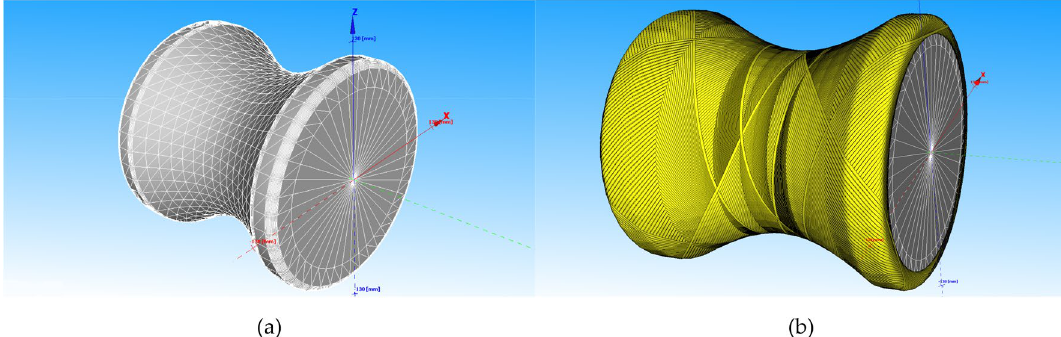
Figure 5. ( a ) The finite element model of reinforced layer. ( b ) The non-geodesic winding pattern with the initial winding angle of 52.5 degrees. Both figures were created with CADWIND v10. URL: https ://www.mater ial.be/cadwi nd/intro /.